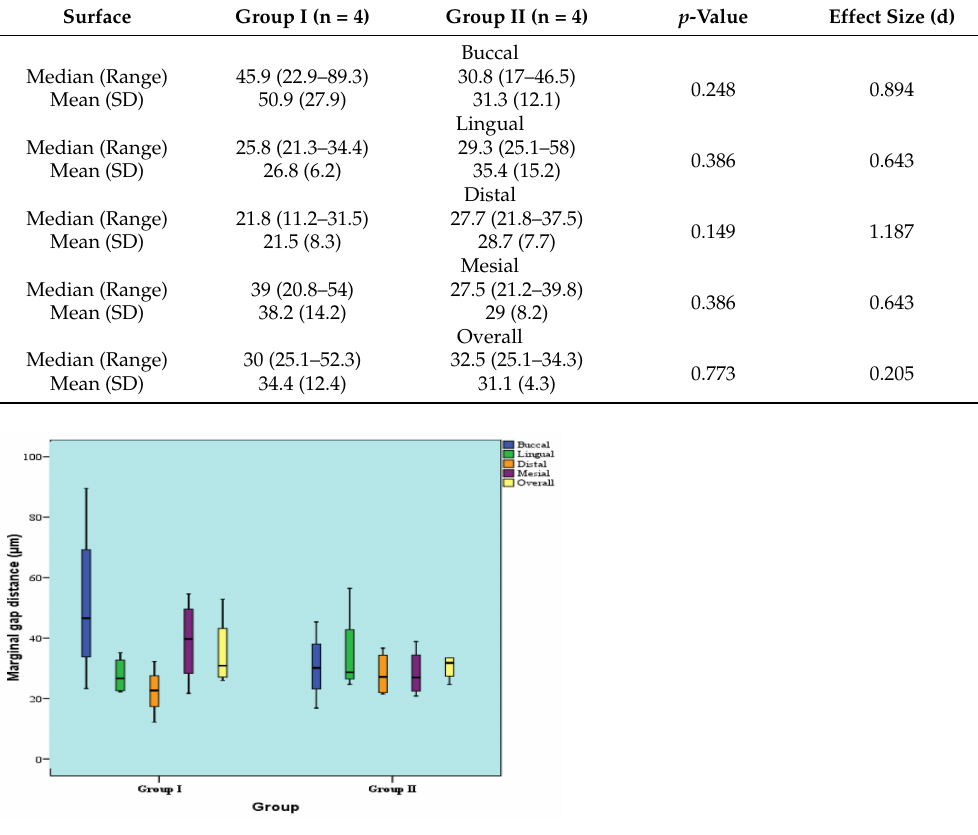
Figure 16. Box plot representing median and range values for marginal gap distances in two groups (mesial retainer).